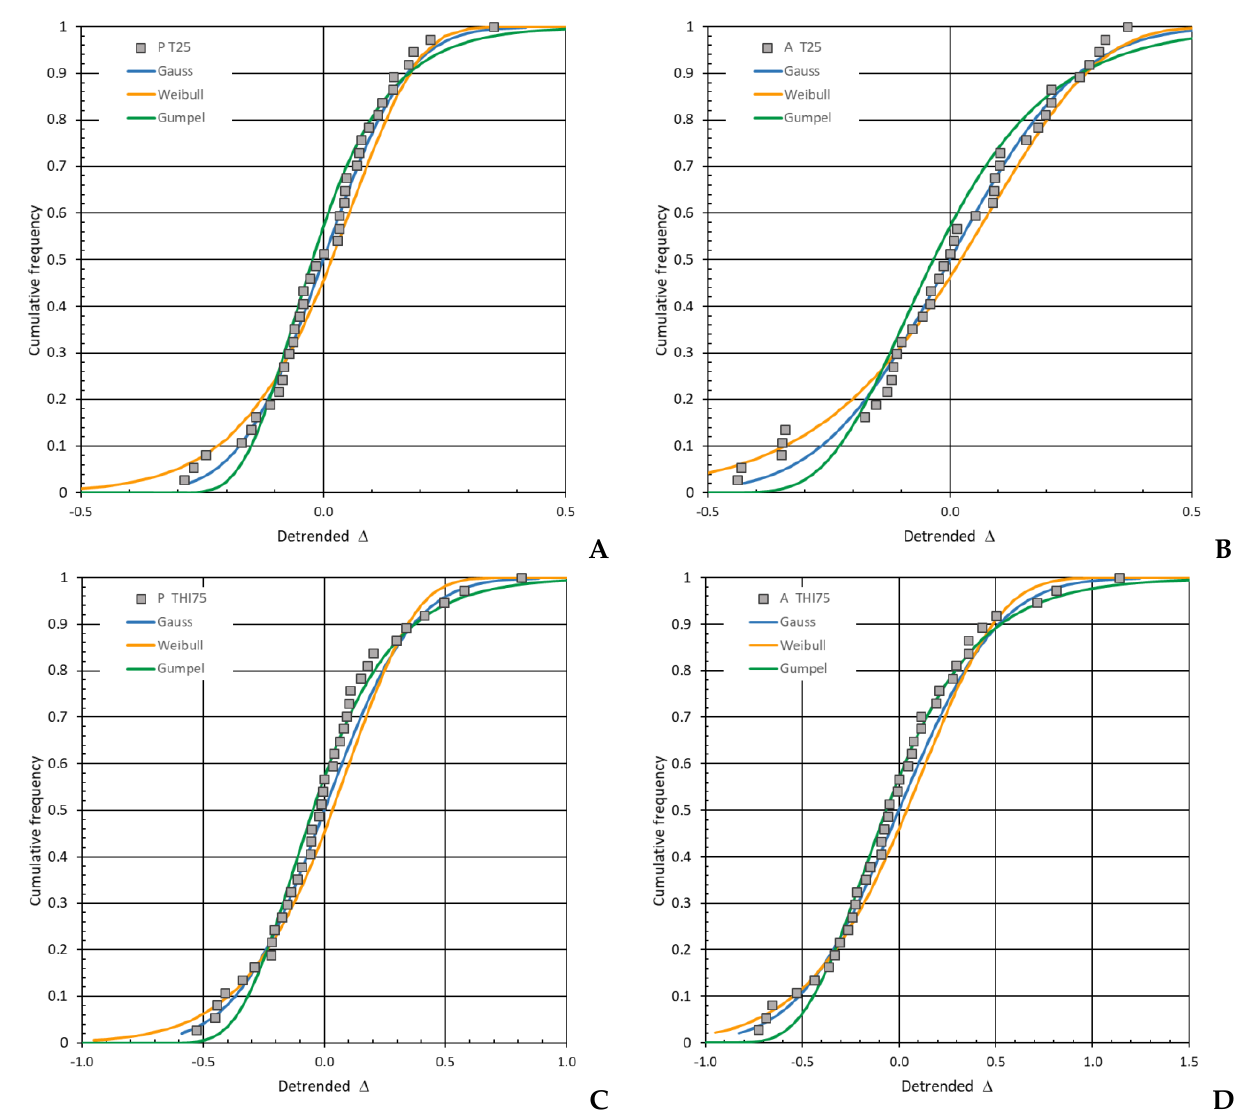
Figure 3. Cumulative distribution of the detrended (and logarithmically transformed) heat stress indices ∆ EXT and three cumulative distribution functions: Gauss, Weibull and Gumbel distribution for the four weather-related heat stress indices P T25 ( A ), A T25 ( B ), P THI75 ( C ), and A THI75 ( D ), describing the variability of HS.